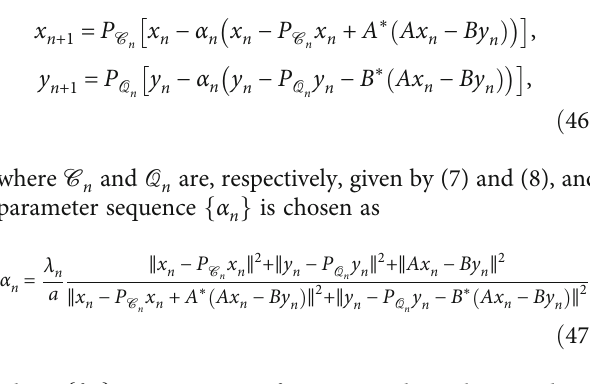
Algorithm 3. For any arbitrary initial guess ð x